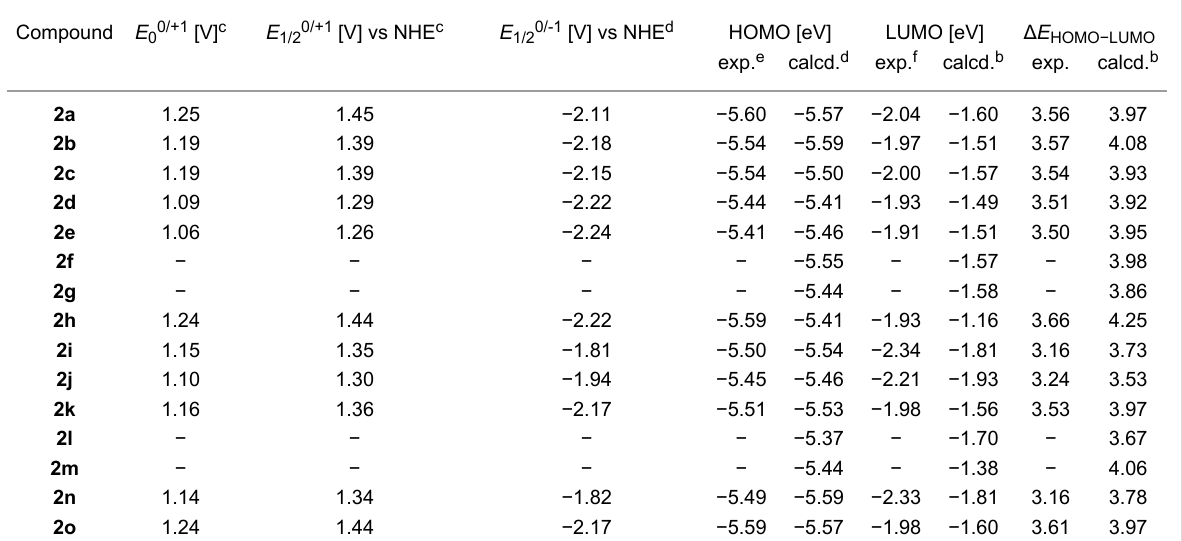
Table 3: Selected cyclovoltammetric a (recorded in dichloromethane at 293 K) and computational b data.